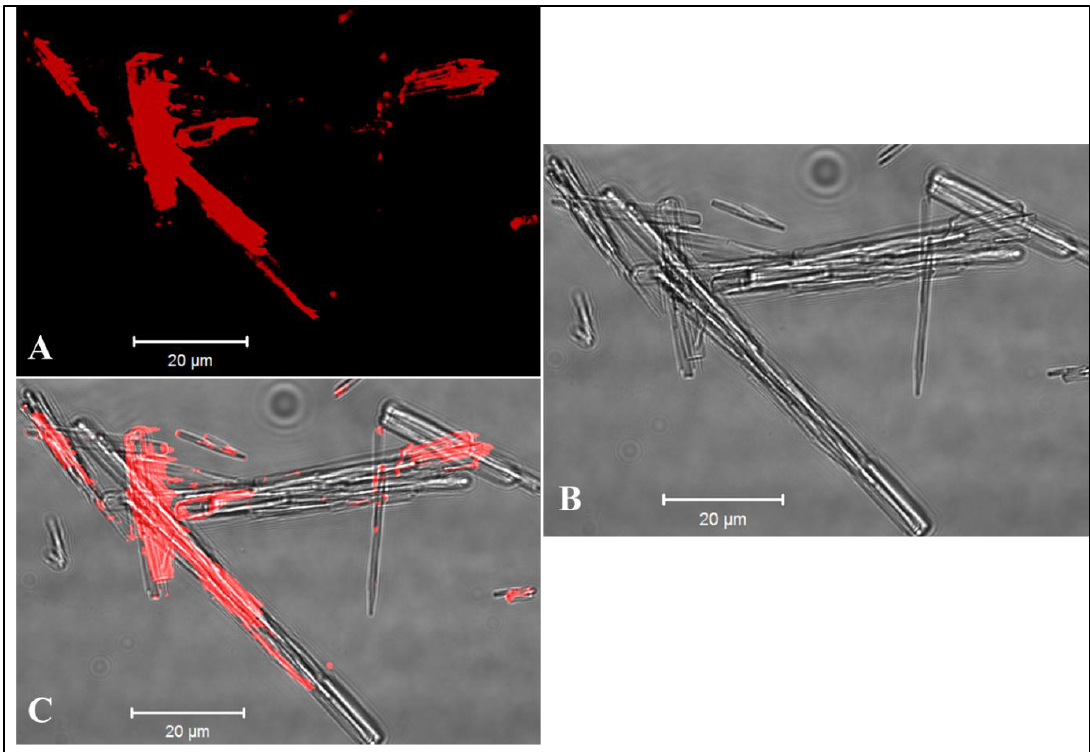
Figure 3. CMVtt CMV was labelled with Alexa Fluor 488 and formulated with microcrystalline tyrosine (MCT). Crystals were analysed by confocal microscopy. ( A ) Fluorescence of CMVttVLP; ( B ) bright field; and ( C ) Overlay.